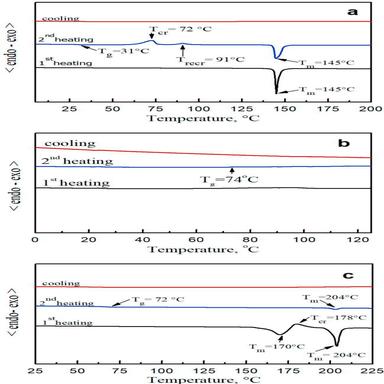
DSC curves of DEF-Ph (a), DEF-BPh (b) and DEF-Naph (c) compounds. Heating rate: 10 ◦C/min.